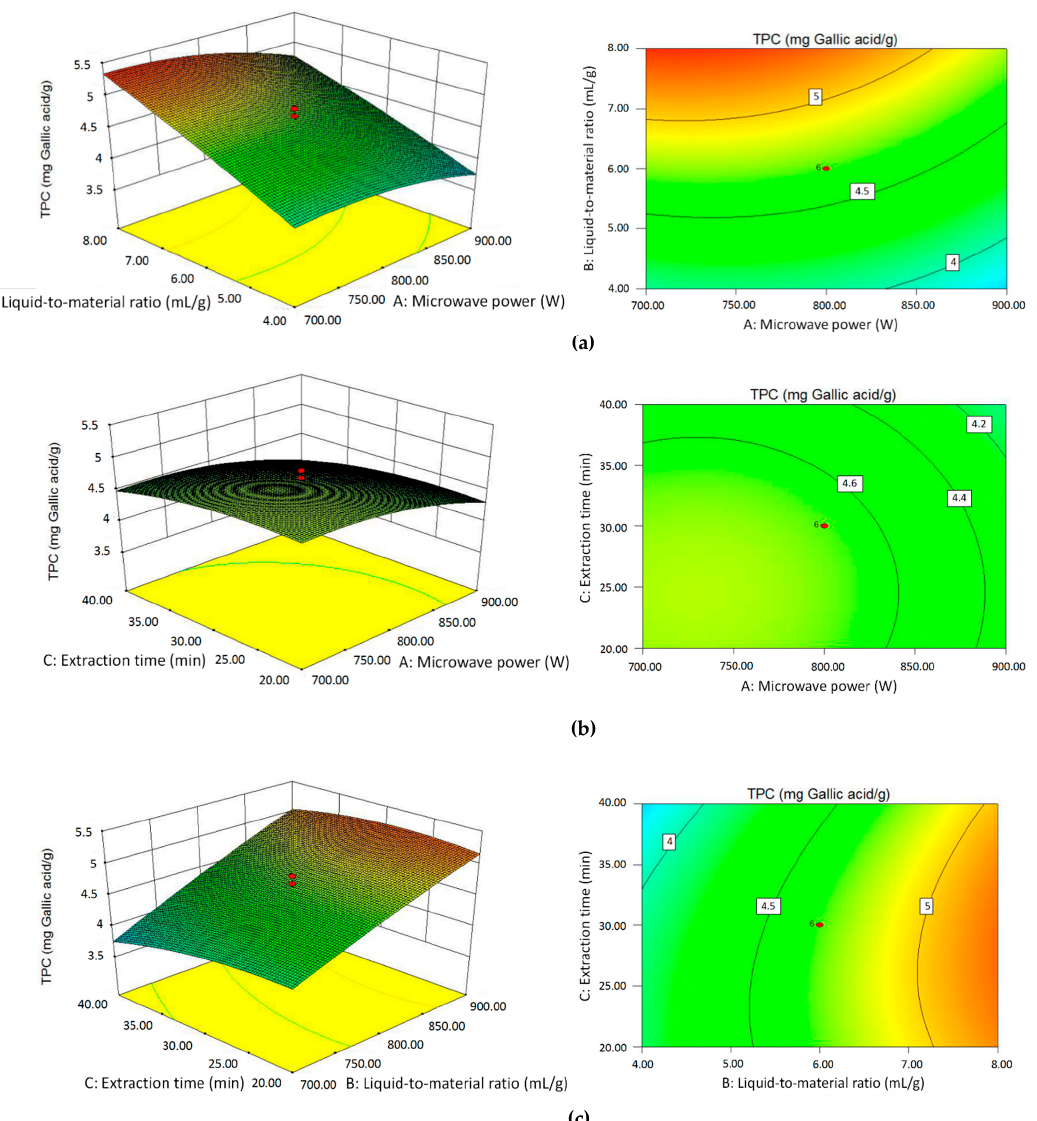
Figure 3. The three-dimensional response surfaces and contour plots of the TPC value a ff ected by microwave power and the liquid-to-material ratio ( a ); microwave power and extraction time ( b ); and liquid-to-material ratio and extraction time ( c